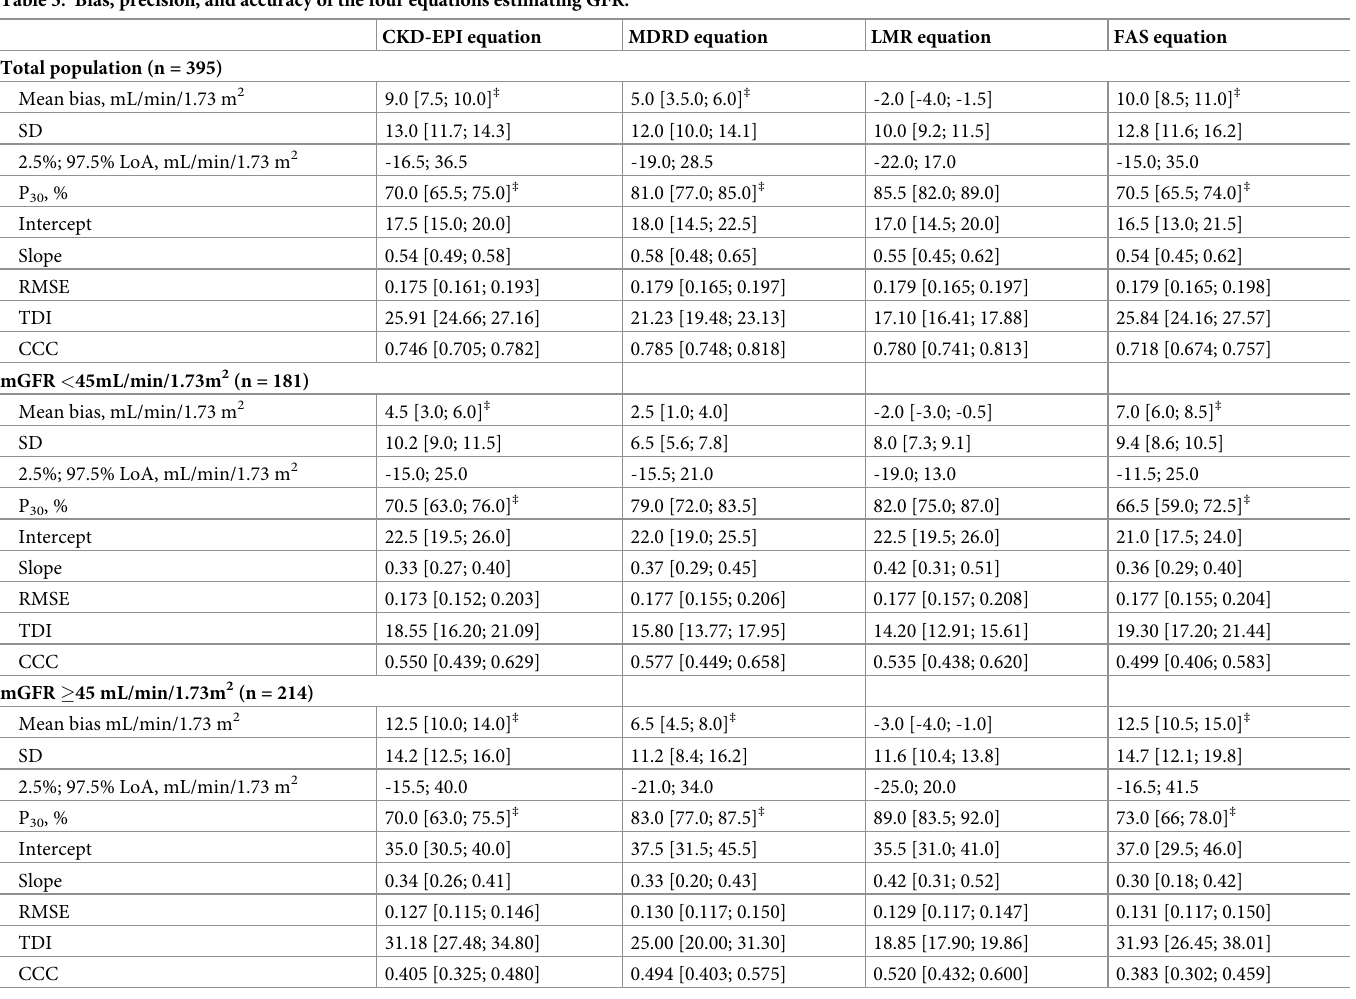
Table 3. Bias, precision, and accuracy of the four equations estimating